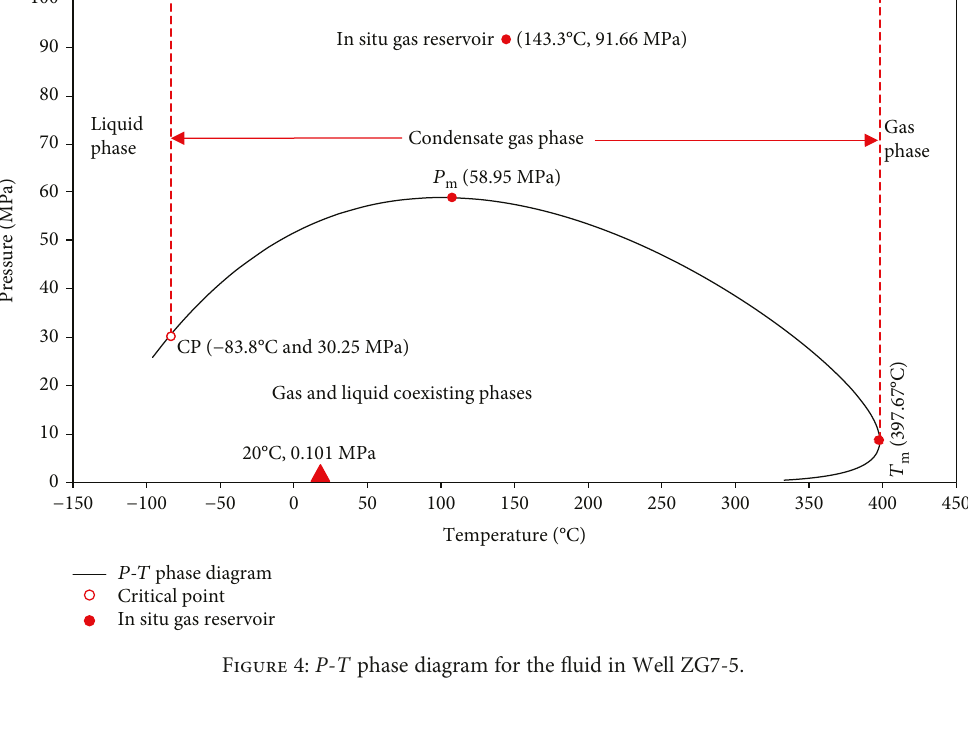
Figure 4: P ‐ T phase diagram for the fl uid in Well ZG7-5.